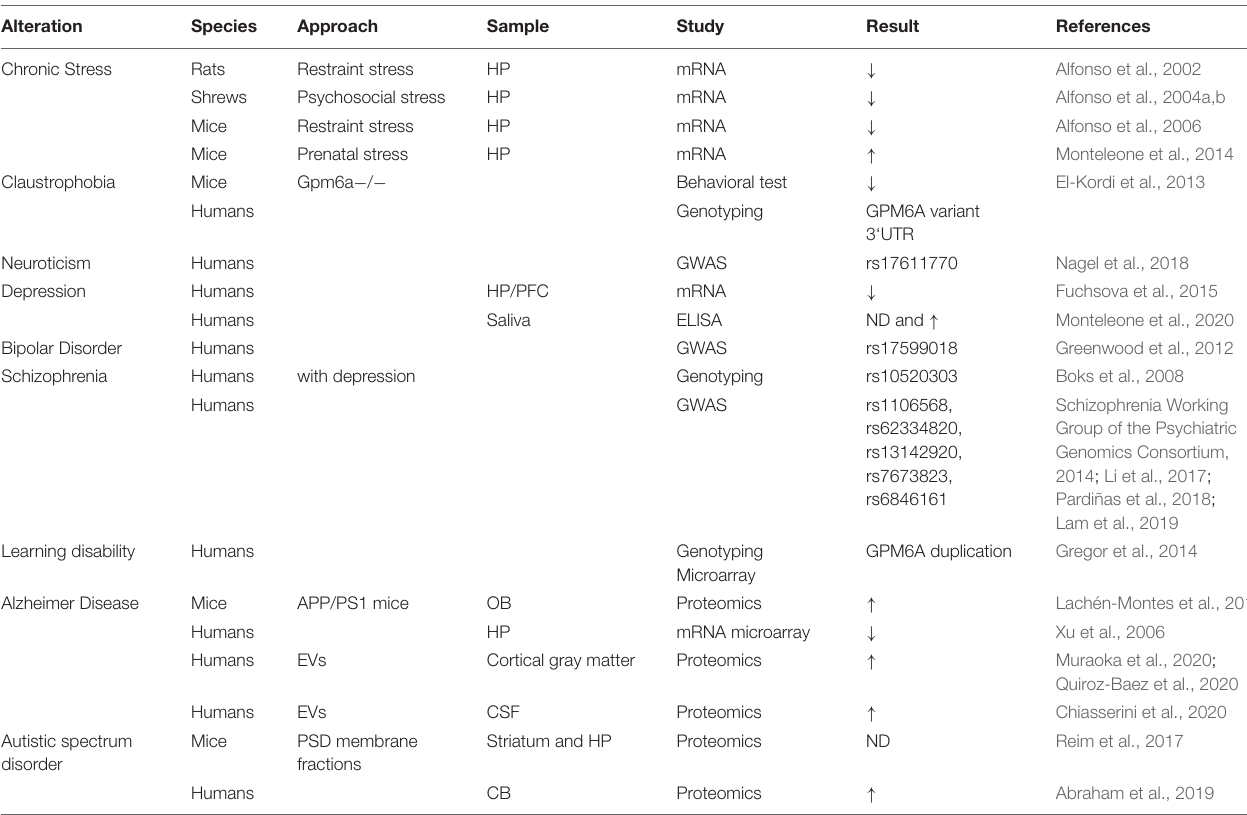
TABLE 1 | Summary of GPM6A gene variants and expression levels related to